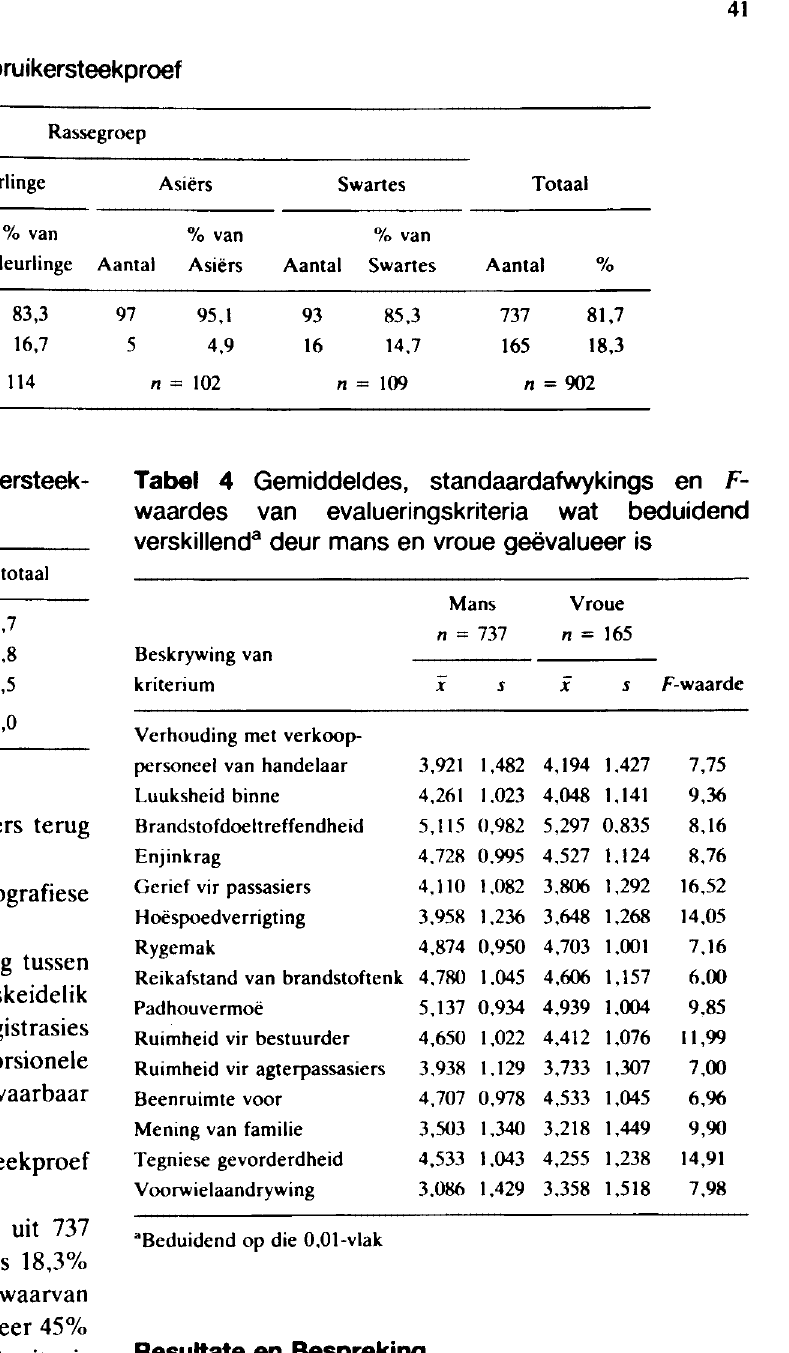
Tabel 3 toon dat die verbruikerssteekproef uit 737 mans en 165 vroue bestaan het. Vroue het dus